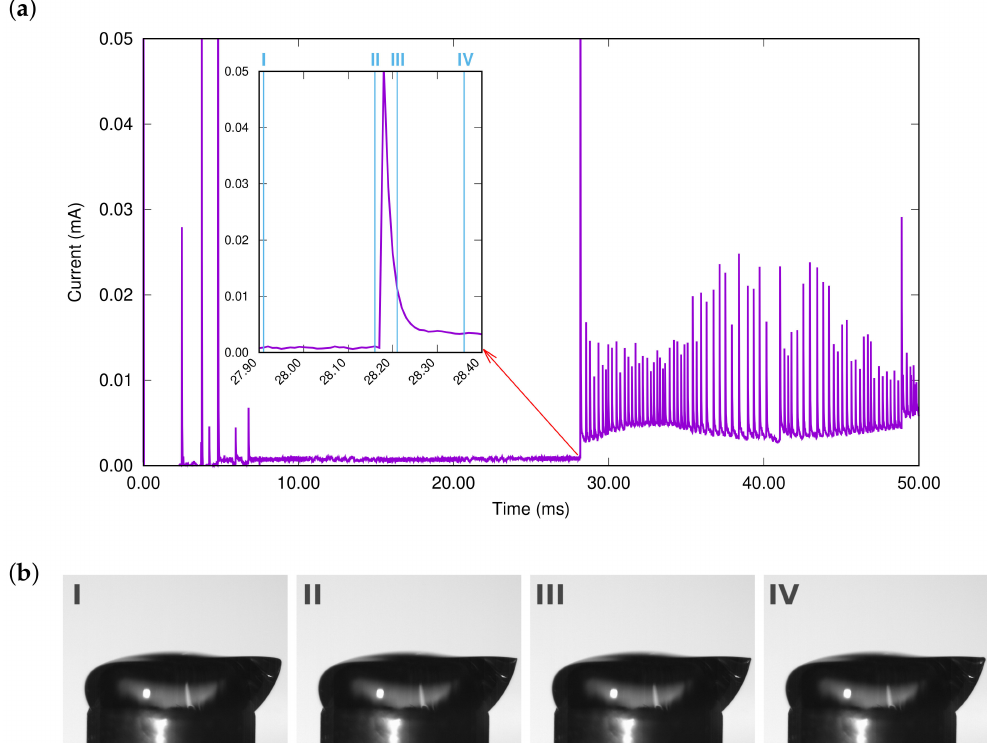
Figure 28. ( a ) Current through electrodes as a function of time measured from the introduction of voltage. The inset shows the details of the current onset. ( b ) A sequence of photographs taken at the times marked by blue vertical lines (with matching Roman numerals) in the inset above. Experiment was done in setup I with sample b0 at 24.6 ◦ C and relative humidity 41%. Photographs were exported from the record of the Olympus i-SPEED 720 high-speed camera using i-SPEED Software Suite